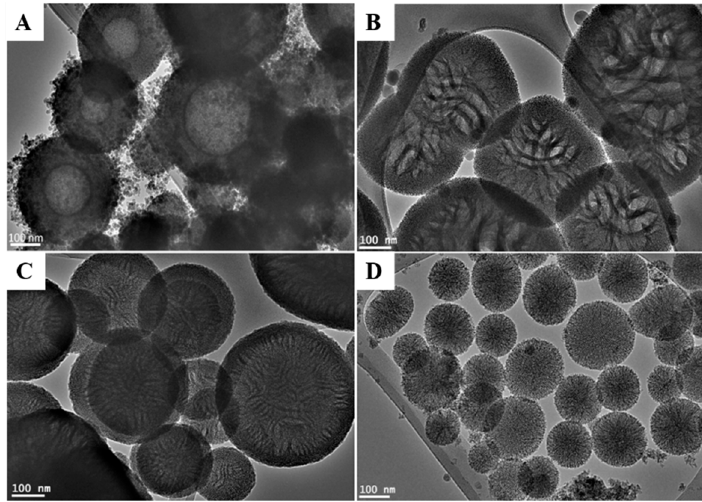
Figure 1. TEM images of MSN-NH 2 prepared with different volumes of 3-aminopropyltriethoxysilane (APTES): ( A ) 50 µL, ( B ) 75 µL, ( C ) 100 µL, and ( D ) 150 µL. Scale bar = 100 nm.